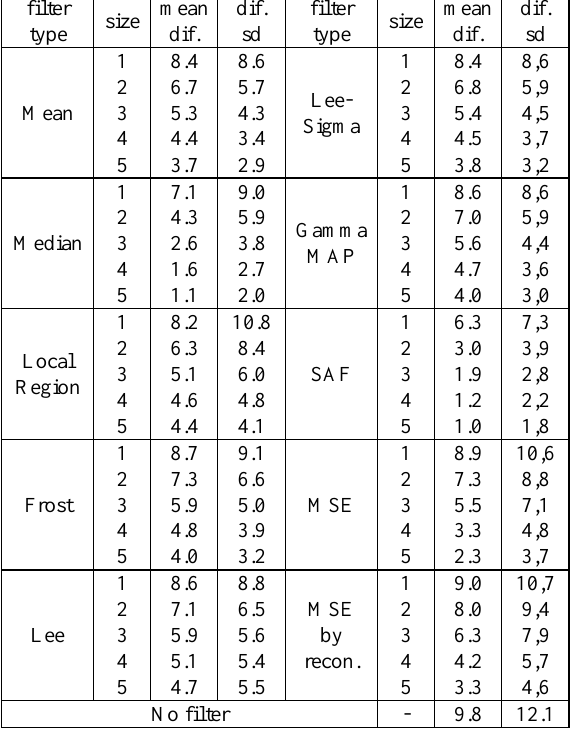
Table 1. Comparison of results of selected filtration of the simulated speckled homogenous image with a noise-free reference image; mean dif . is the mean value of the differential image, and dif. sd is its standard deviation value